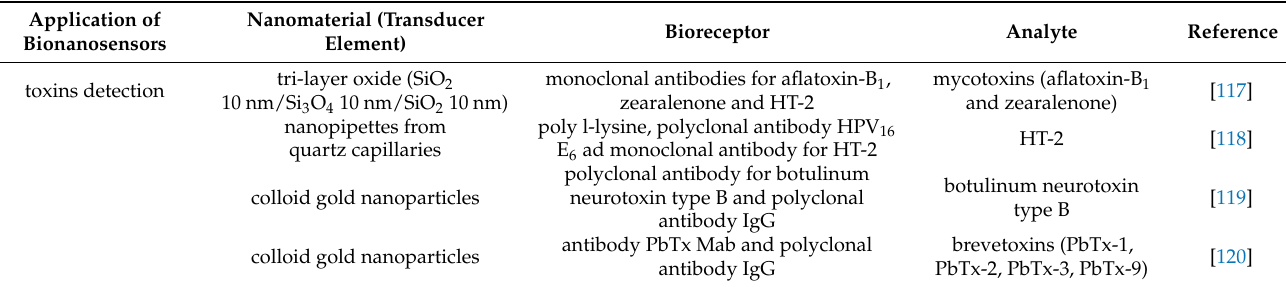
Table 4. Summary of different possible applications of bionanosensors in food